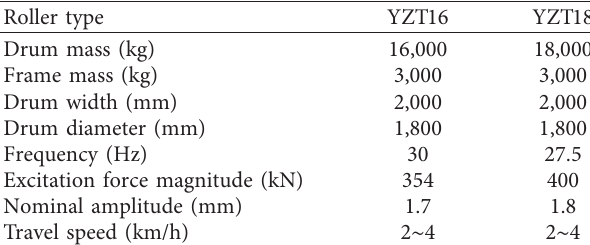
Table 3: Properties of the roller YZT16 and